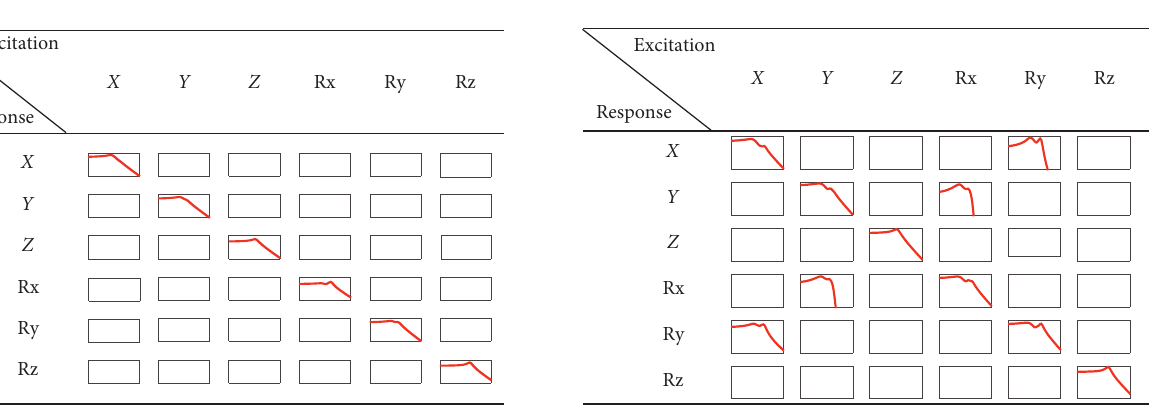
Figure 8: Response of the CMG when h � 0mm. Figure 9: Response of the CMG when h �